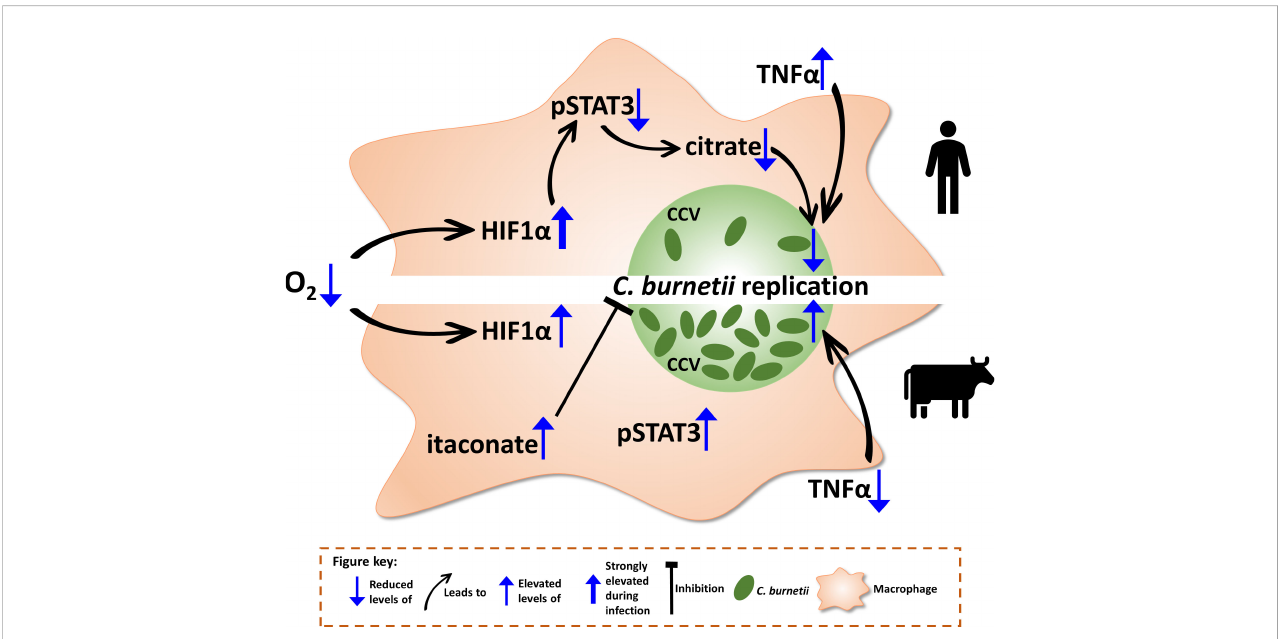
FIGURE 10 Schematic model of the consequences of hypoxia on bovine and human macrophages infected with C. burnetii . When oxygen (O 2 ) levels drop, the transcription factor hypoxia-inducible factor 1-alpha (HIF1 a ) is stabilized. While in human macrophages (hM F ), a C. burnetii infection leads to an elevation of HIF1 a stabilization, HIF1 a levels in bovine macrophages (bM F ) are not altered upon infection. In infected hM F , HIF1 a prevents activation of signal transducer and activator of transcription 3 (STAT3) by phosphorylation, which in turn causes a decrease in intracellular citrate levels, leading to the impediment of C. burnetii replication. However, this impairment of STAT3 activation by HIF1 a is not observed in bM F causing phosphorylation of STAT3. Furthermore, the tumor necrosis factor alpha (TNF a ) secretion is increased in hypoxic hM F correlating with the control of C. burnetii replication. In contrast, TNF a secretion is blocked in bM F , eliminating the factor of control over C. burnetii . Thus, C. burnetii is able to replicate. Finally, itaconate levels are increased in bM F , which have been shown to inhibit C. burnetii